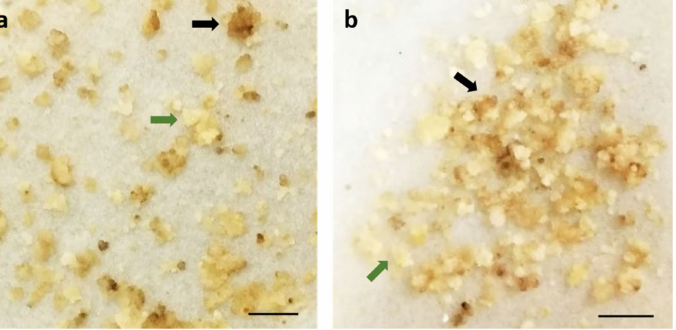
Figure 2. Tamarillo embryogenic callus inoculated with EHA105 ( a ) and LBA4404 ( b ) Agrobacterium strains, in selective media for 16 weeks and subcultured in increasing antibiotic concentration every 4 weeks. The black arrows show kanamycin-non-resistant cells, while the green arrows show kanamycin-resistant cells. Bars represent 0.5